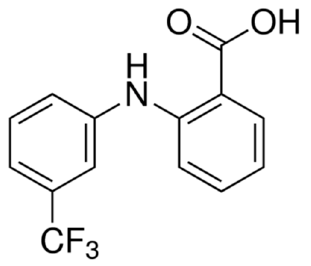
Figure 1. Molecular structure of flufenamic acid (FFA).